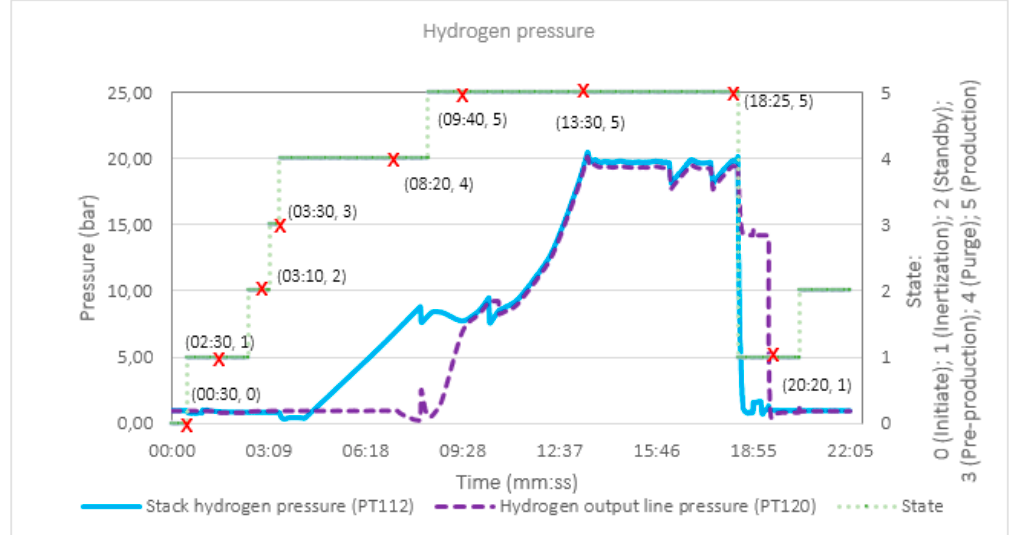
Figure 18. Experimental results. Hydrogen line pressure evolution during a start-stop cycle.